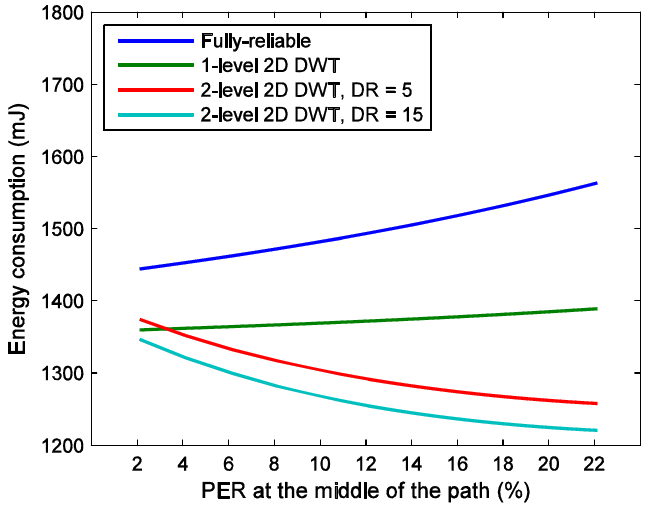
Figure 10. Energy consumption for a path with different mean packet error